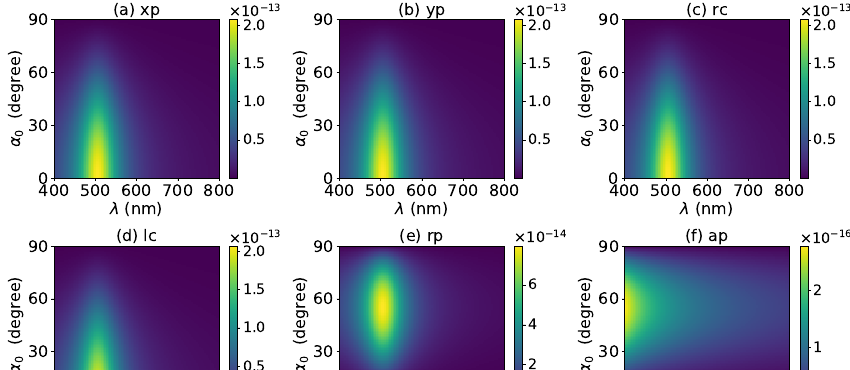
Figure 5. The same as in Figure 2, but with N = 3.